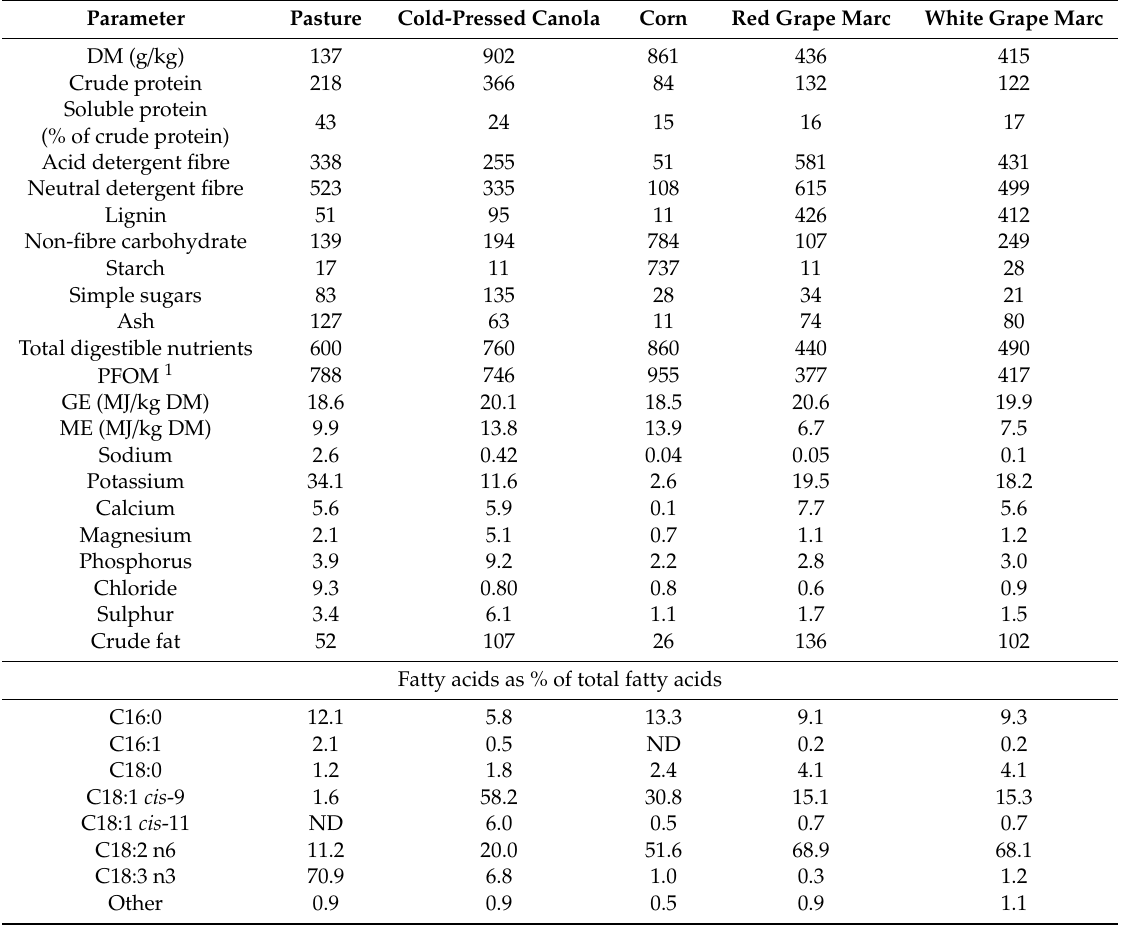
cows o ff ered the CON diet (Table 8). Dietary treatment had no e ff ect ( p = 0.728) on the concentrations of total VFA in ruminal fluid. The RGM diet was associated with smaller percentages (of total VFA) of acetic ( p = 0.002) and caproic acids ( p = 0.001) and greater percentages of propionic ( p = 0.001) and iso-butyric acids ( p = 0.003) than the WGM diet (Table 8). The acetic to propionic ratio in the ruminal fluid from cows o ff ered the RGM diet was smaller ( p = 0.001) than the ratios in the ruminal fluids of